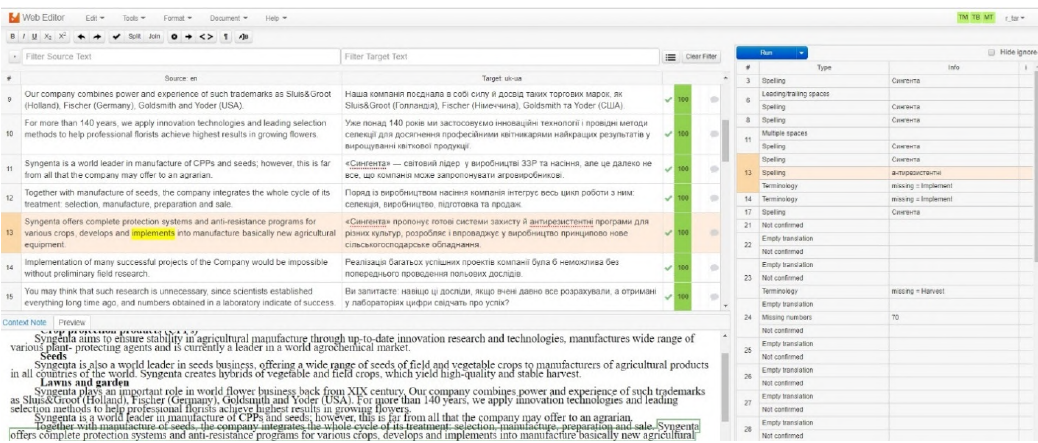
was presented in a special window, the student was able to fill in variants of the target text in different ways (figure 5). These included: writing the target text manually from the keyboard; substituting a suggested translation variant based on the translation results in the selected machine translation system; substituting a suggested translation variant based on the results of a match with a segment in the connected translation memory, selecting the corresponding individual term suggested from the terminology database.